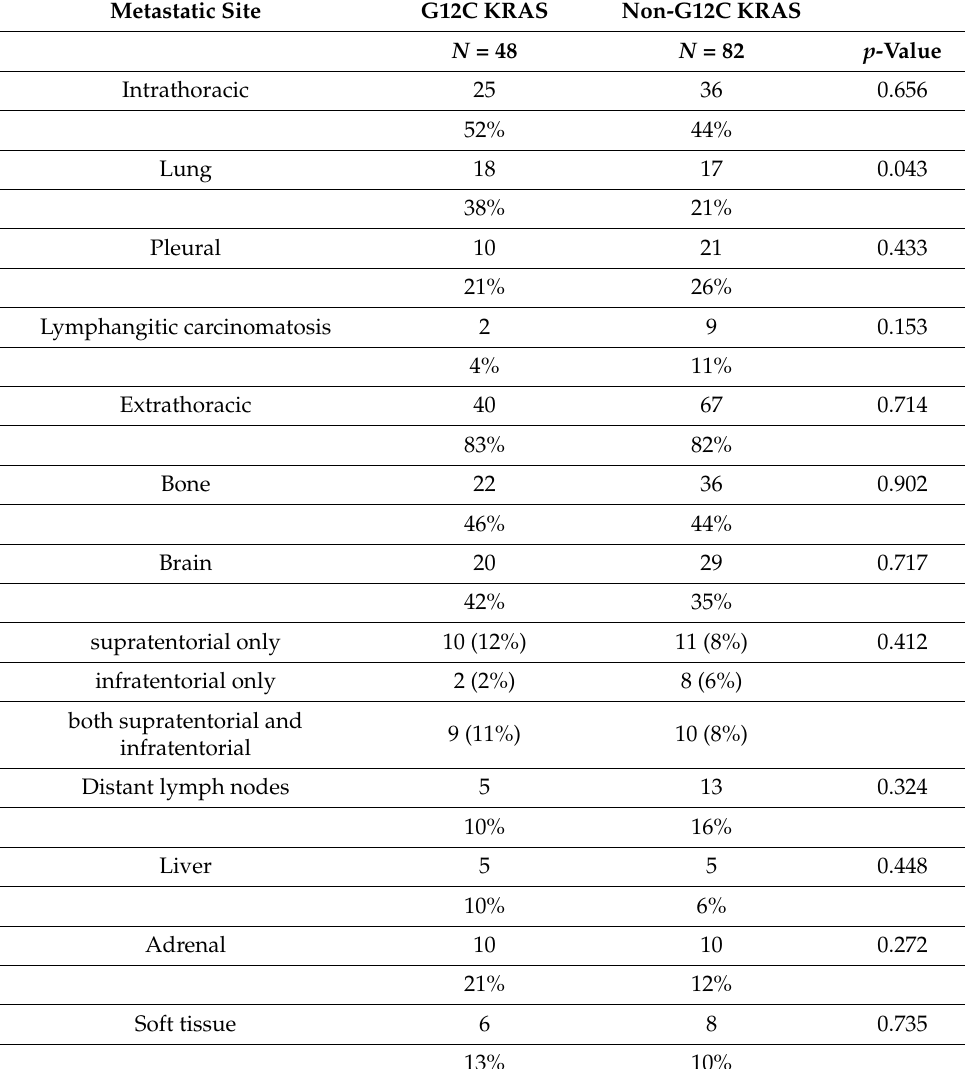
Table 3. Pattern of metastases in G12C and non-G12C KRAS positive